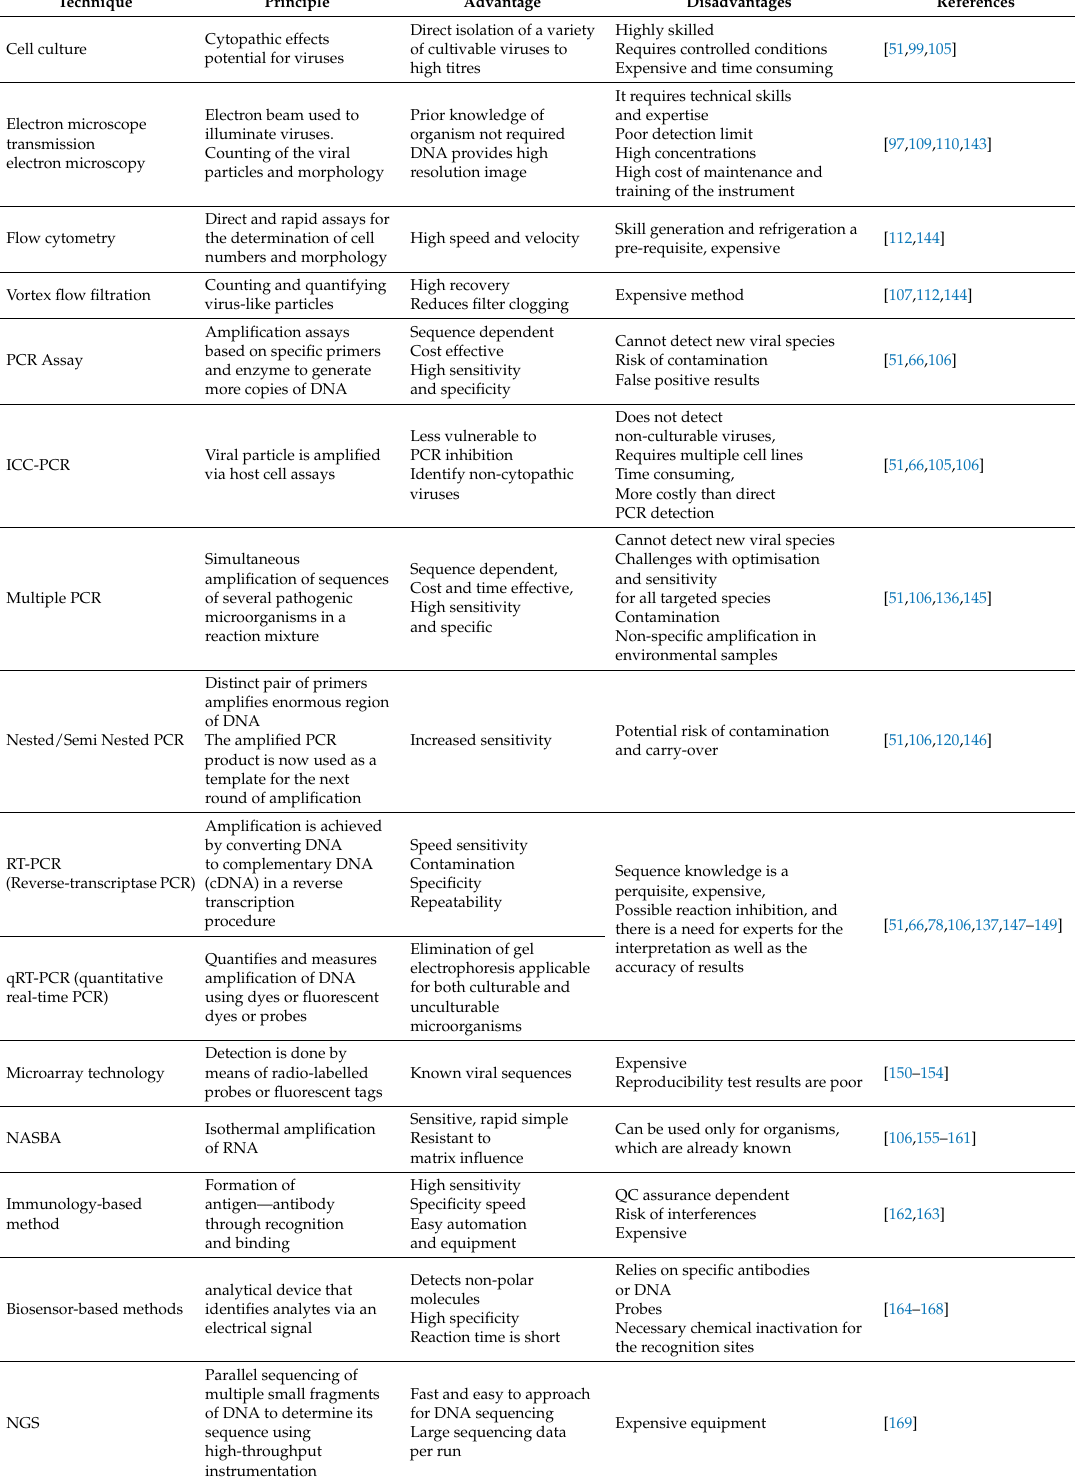
Table 4. Summary of the Pros and Cons of molecular methods for HEV